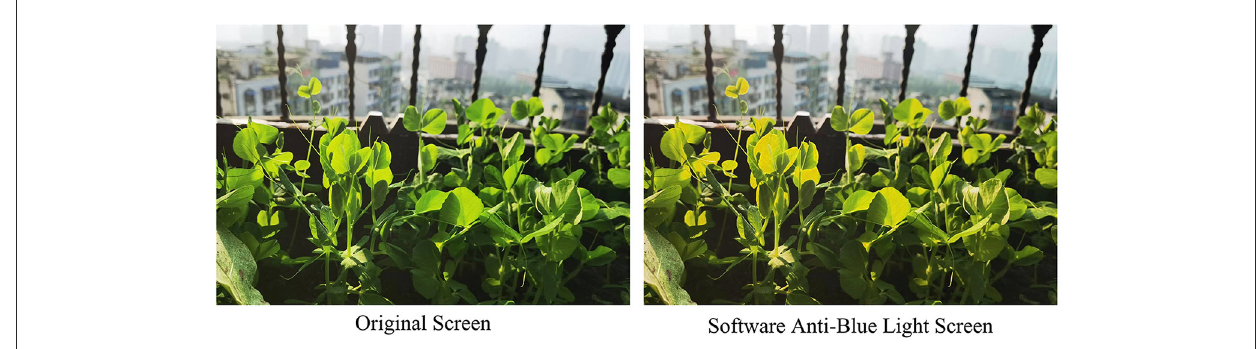
FIGURE2 Display color cast caused by anti-blue light technology